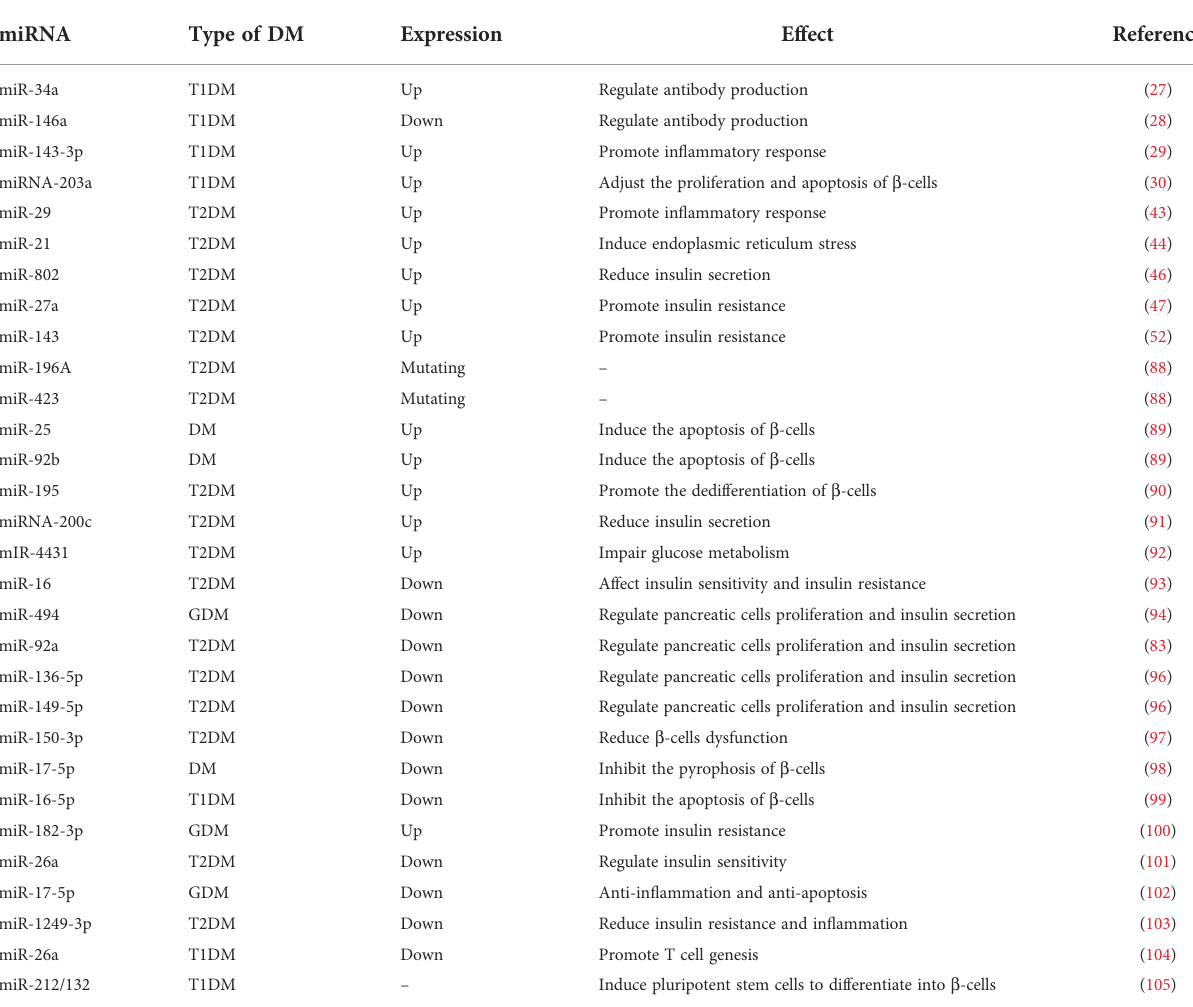
TABLE 1 The role of miRNAs in diabetes mellitus.